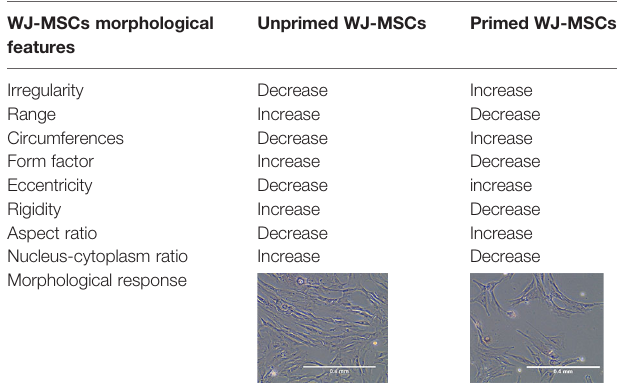
Morphological features were investigated using Evos Cell Imaging System at 20X magni fi cation and the morphological variations were analyzed by ImageJ software.